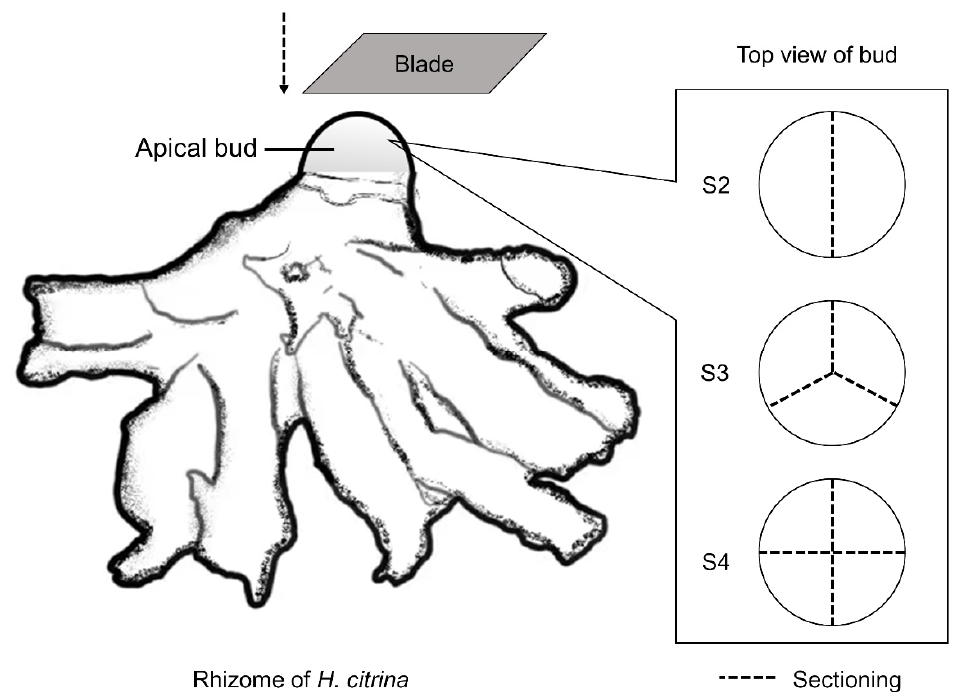
Figure 1. Schematic diagram of sectioning rhizomes in EXP.2. Note: S2, S3 and S4 refer to two equal sections, three equal sections and four equal sections, respectively in Experiment 2.